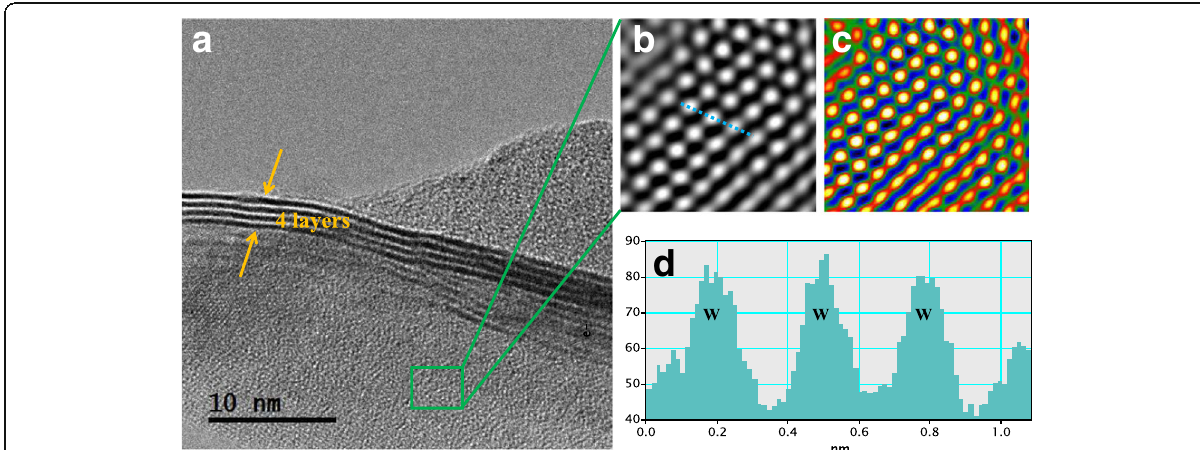
Fig. 3 HRTEM image of a vertical 1T-WS 2 nanosheets and b , c false-color images responding to the amplification of a . Intensity profiles along the light-blue line indicated in image b is shown in image